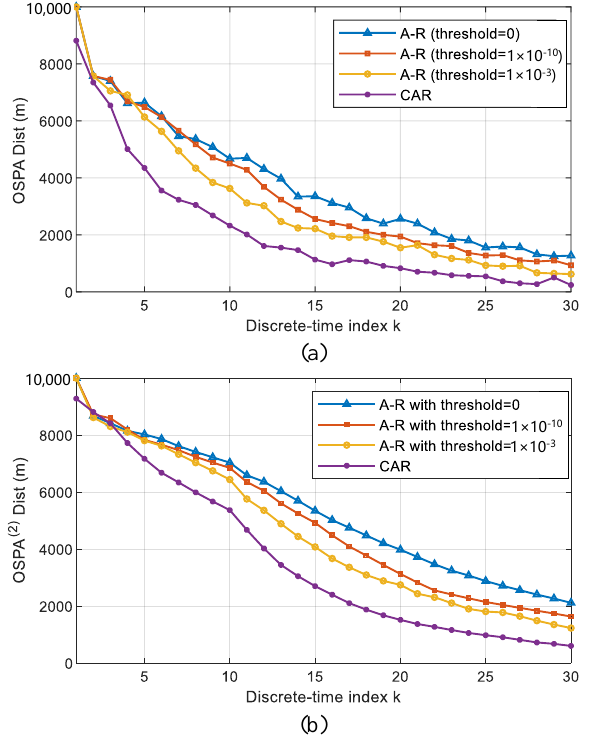
Figure 10. Performance comparison in Scenario 1: ( a ) OSPA distance; ( b ) OSPA ( 2 ) distance. Table 1. Average performance comparison in Scenario